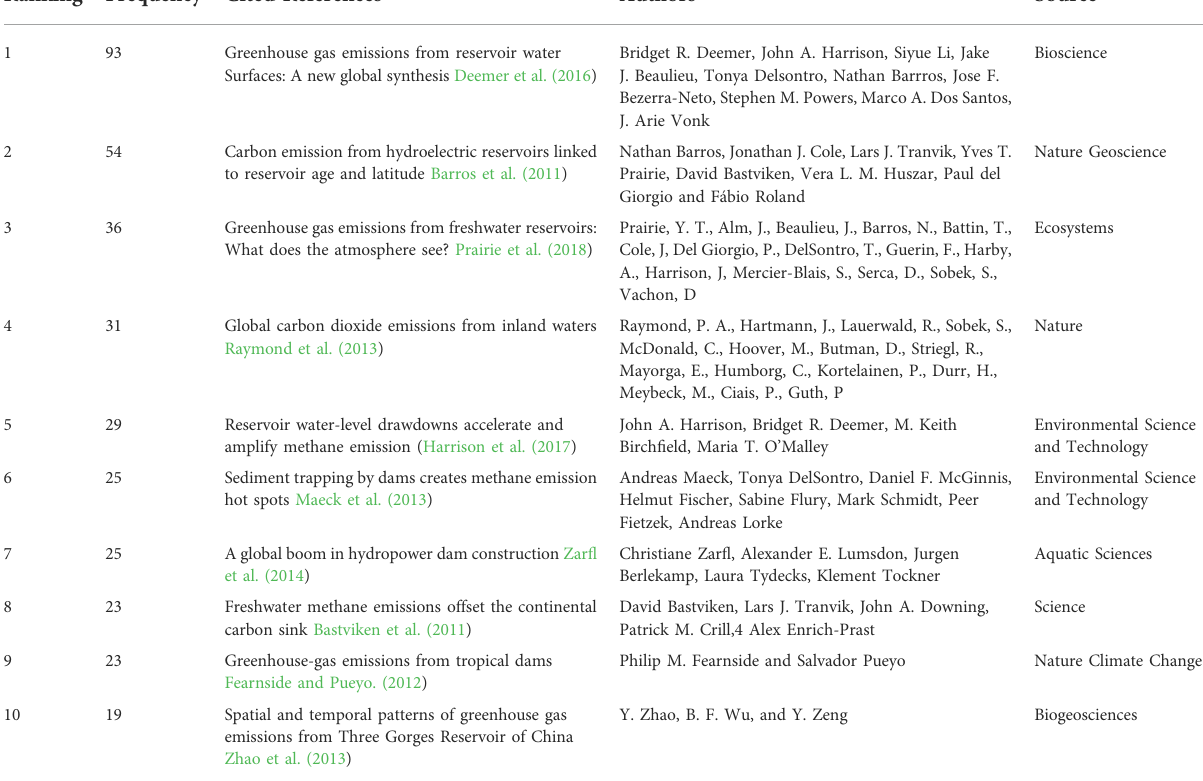
TABLE 7 Top fi ve references cited in GHG-HR research fi